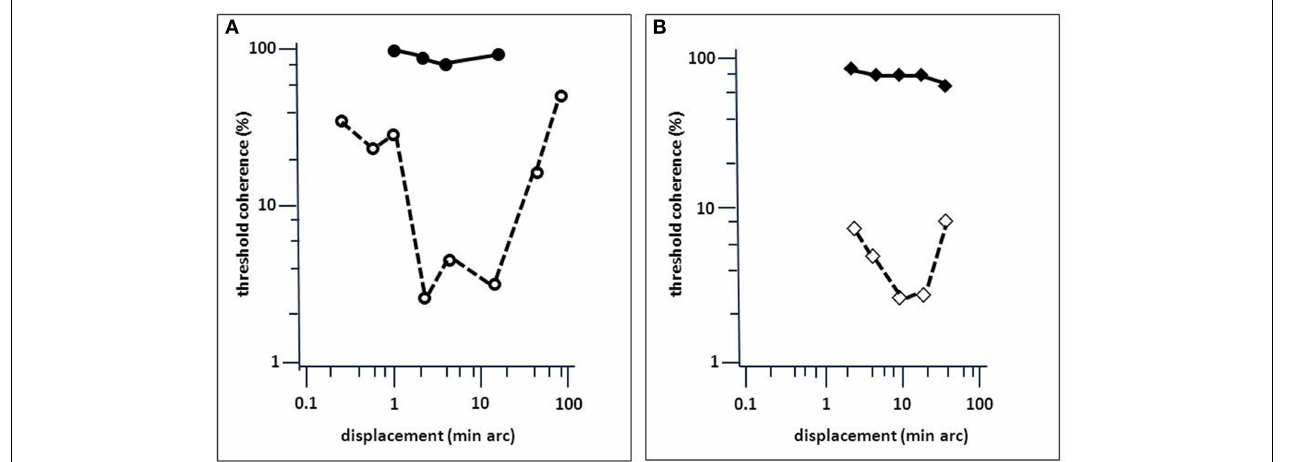
FIGURE 5 | Comparison of LM’s performance in a motion-coherence task with that of MT-lesioned monkey (Newsome and Paré, 1988). (A) Threshold coherence values for the Movshon noise stimulus as a function of spatial stimulus displacement for LM (filled circles) and an age-matched normal subject (open circles; same as in Figure 4 ). (B) Same as (A) , but for